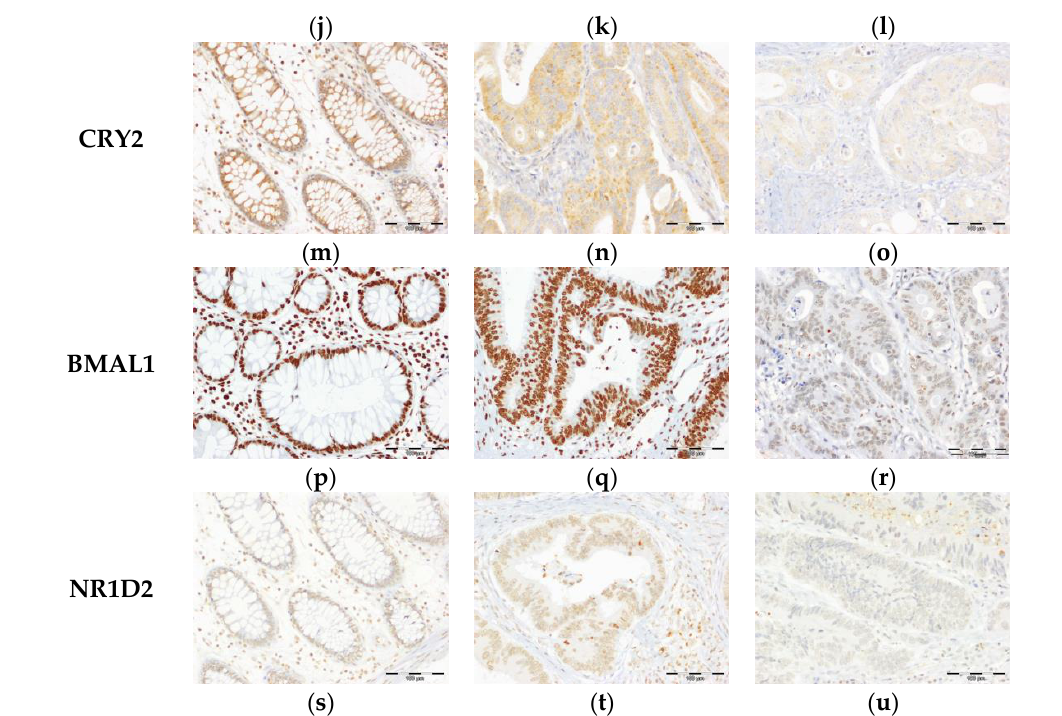
Figure 1. IHC staining of PER1 ( a – c ), PER2 ( d – f ), PER3 ( g – i ), CRY1 ( j – l ) CRY2 ( m – o ), BMAL1 ( p – r ) and NR1D2 ( s – u ) in normal colonic mucosa ( a , d , g , j , m , p , s ) and primary tumours of CRC with high ( b , e , h , k , n , q , t ) and low ( c , f , i , l , o , r , u ) staining. Magnification: 200×. Table 3. Expression of circadian clock-related proteins in normal and tumour colorectal